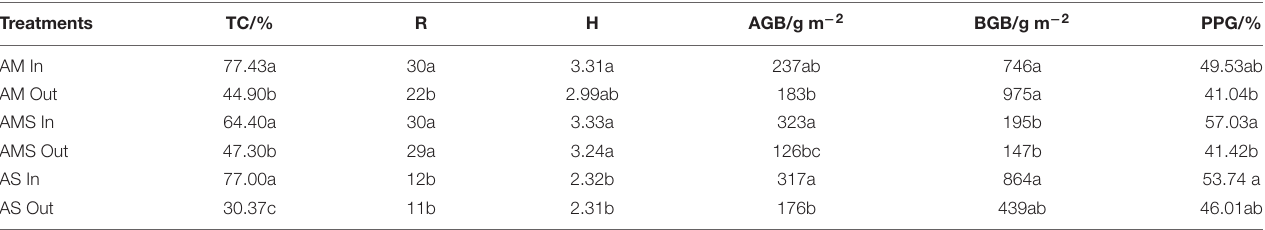
TABLE 2 | Comparisons of total coverage (TC), species richness (R), Shannon–Wiener diversity index (H), aboveground biomass (AGB), belowground biomass (BGB), percentage of palatable grasses (PPG), between enclosed (In), and grazed (Out) sites with the three vegetation types: alpine meadow (AM), alpine meadow steppe (AMS), and alpine steppe (AS).